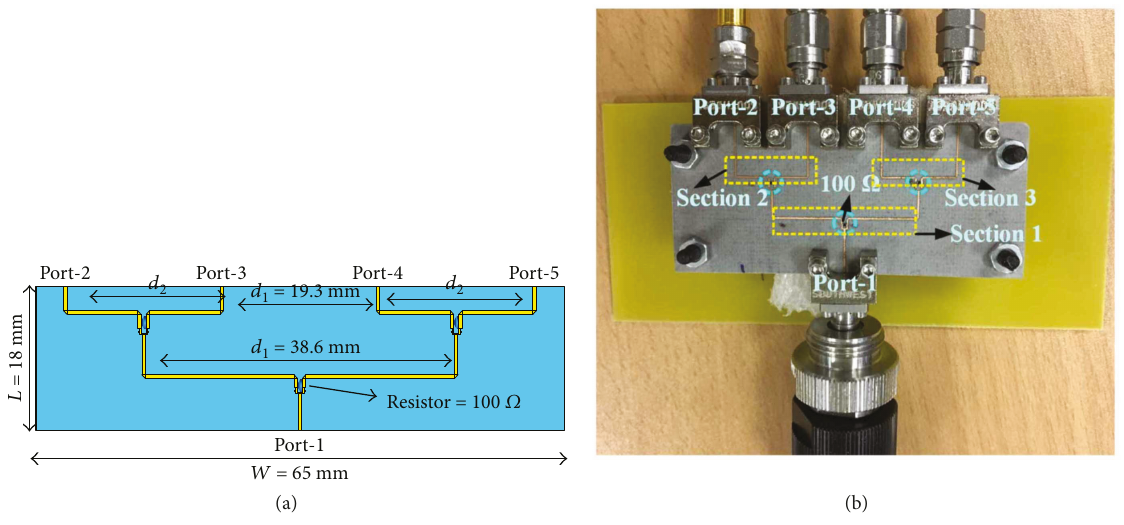
Figure 5: (a) Geometric design and dimensions of M3WPD. (b) Realized prototype of the